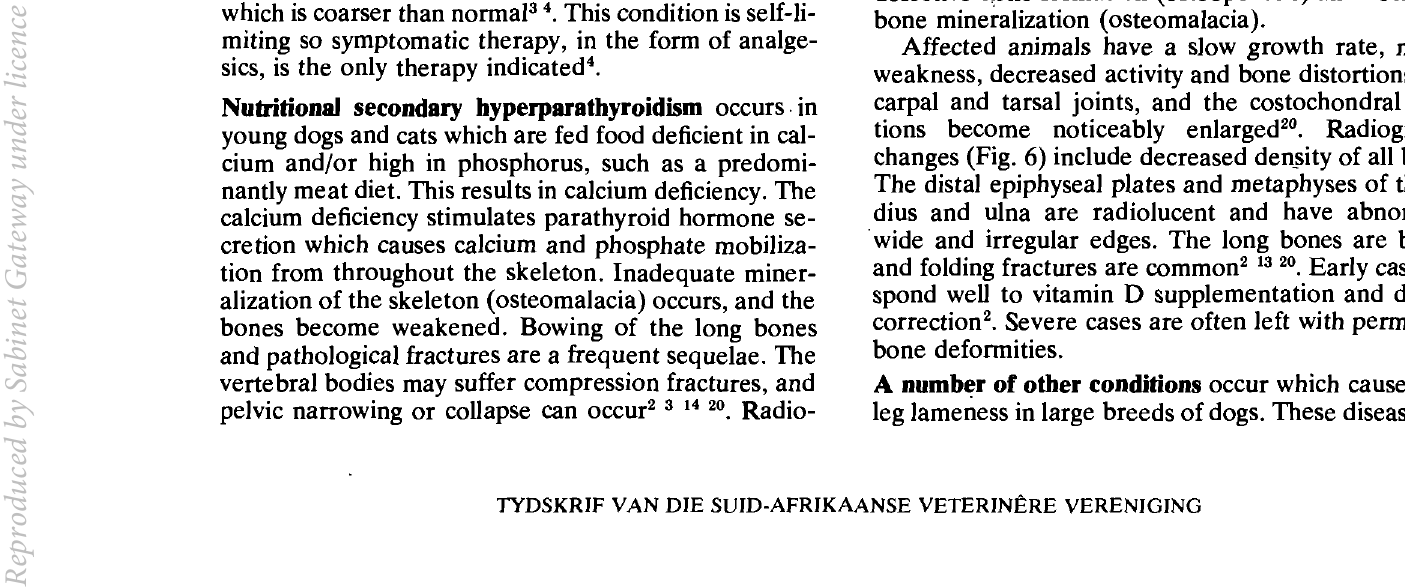
Fig. 3. Diagram of the lateral radiograph of the carpal findings in re tained enchondral cartilage cores. Radiolucent (dark on a radiograph) strip extending from the growth plate, through the metaphysis, into the shaft of the ulna (A). The ulnar me taphysis is of normal size for a growing dog and has an uni form radiopaque (white on a radiograph) appearance (8). Diaphysis of the radius bowed cranialward (C). Normal dia physis of the ulna (D), normal growth plates (E), and normal epiphyses (F).